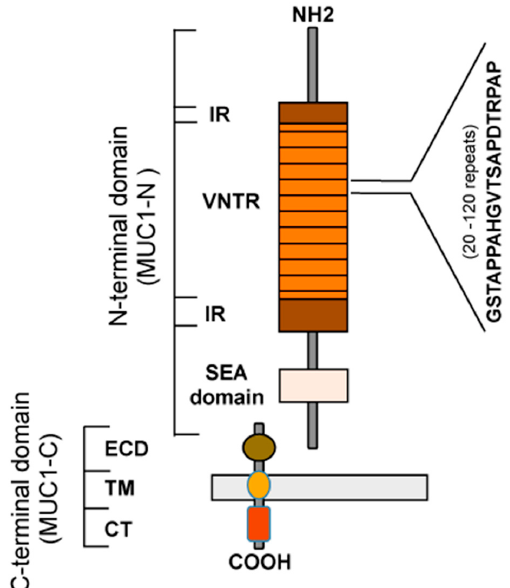
Figure 1. Schematic representation of mucin 1 (MUC1) structure. Abbrevition: CT: cytoplasmic tail; ECD: extracellular domain; IR: imperfect repeat; TM: transmembrane; SEA: sea urchin